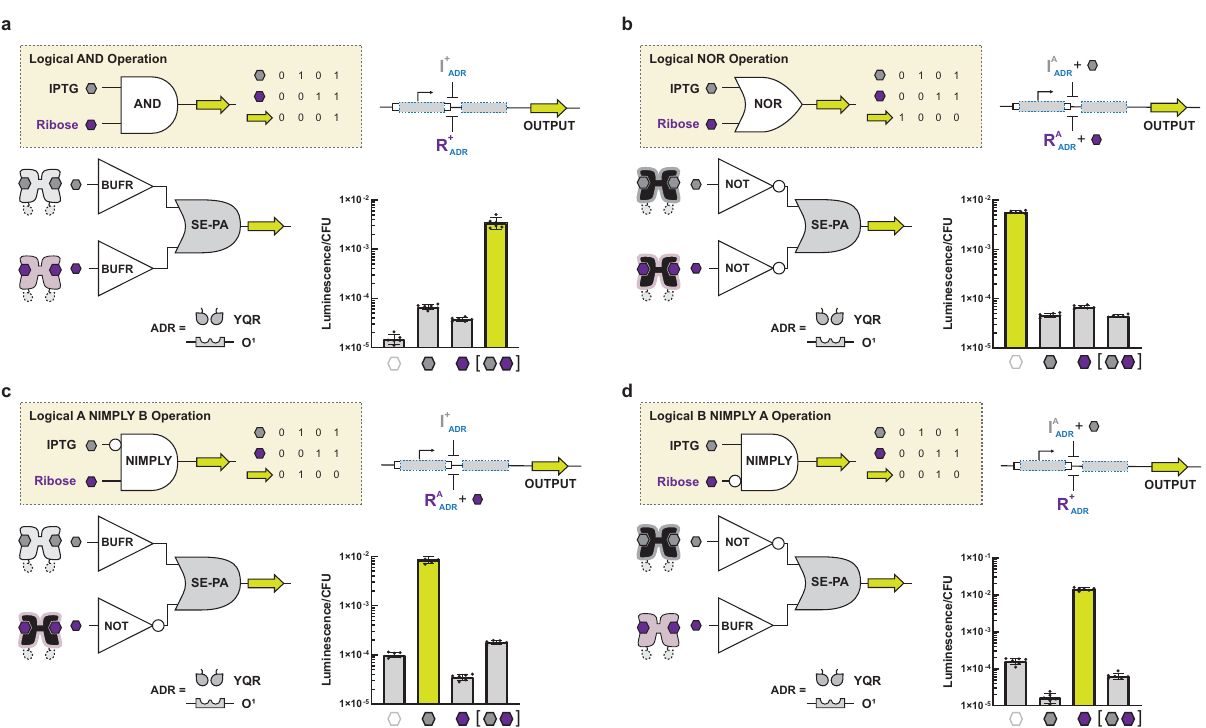
Fig. 2 Single-promoter logic gates constructed in B. thetaiotaomicron . a The AND gate is constructed by directing two repressors to the same operator. We refer to the genetic architecture of directing two or more TFs to a single operator as series-parallel (SE-PA). Bar charts show luciferase activity presented as luminescence per colony forming unit (CFU) (Methods). Each bar corresponds to the ligand condition shown below each bar (empty, no ligand; gray, IPTG; purple, D-ribose; gray and purple, IPTG and D-ribose). Strains harboring logic gates were grown in the presence of all combinations of both inducers (each at a fi nal concentration of 10 mM) and assayed for luciferase activity (Methods). The fold change (presented as the high output state divided by the low output state) is given in Supplementary Fig. 5 for each set of input combinations. b The NOR gate is constructed by directing two anti- repressors to the same operator. c The A NIMPLY B gate is constructed by directing an I + and a R A to the same promoter. d The B NIMPLY A gate is constructed by directing an I A and a R + to the same promoter. Source data are provided as a Source Data fi le. Data represent the average of n = 6 biological replicates. Error bars correspond to the SEM of these